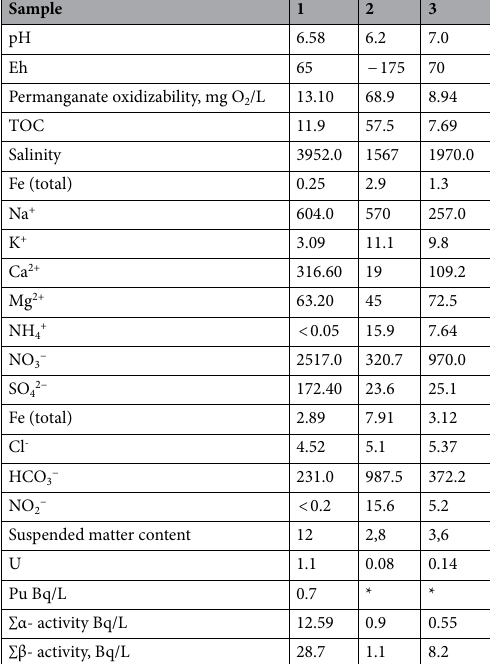
Table 1. Parameters of the groundwater samples, mg/l. The concentrations of cations and anions were measured on a Capel-205 (Russia) new generation capillary electrophoresis system, U by ISP-MS, Pu, ∑α- and ∑β- activity by radiometry. *Below detection